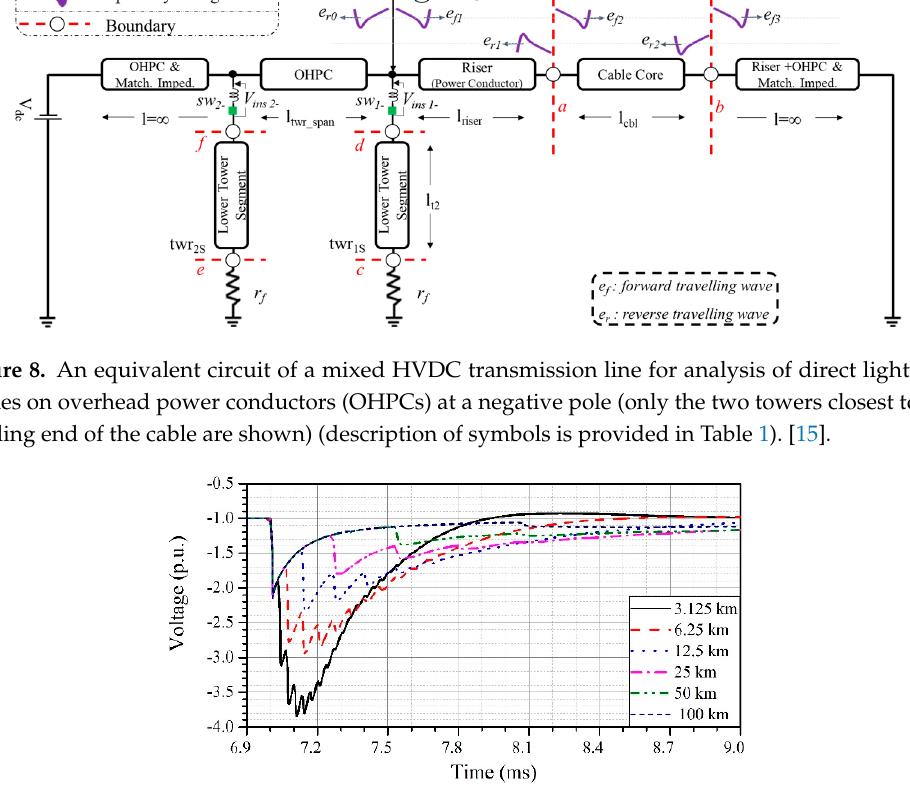
Table 4. Maximum core-ground overvoltage in cables with different lengths. Cable Length (km) Maximum Overvoltage (p.u.) Distance from Sending End (%)